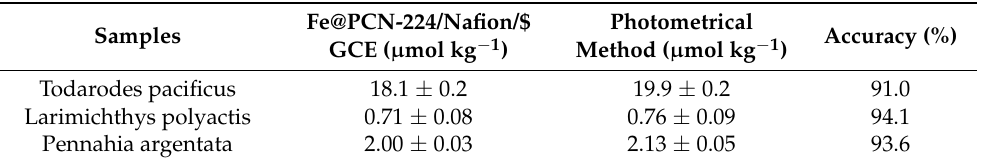
Table 2. H 2 O 2 concentration detected in fresh fish samples by Fe@PCN-224/Nafion/GCE and Photometrical